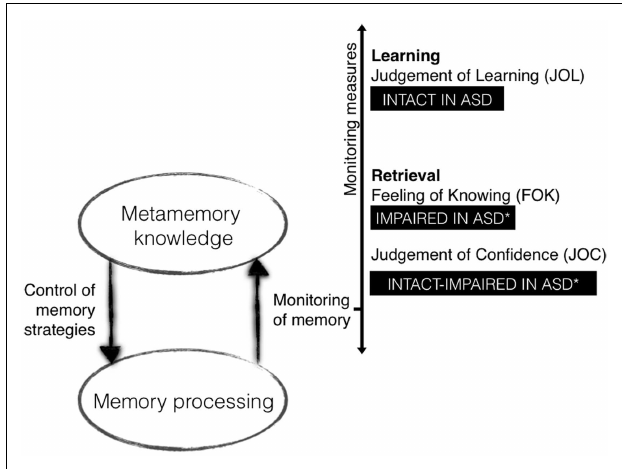
FIGURE 2 | Metamemory findings in autism spectrum disorder